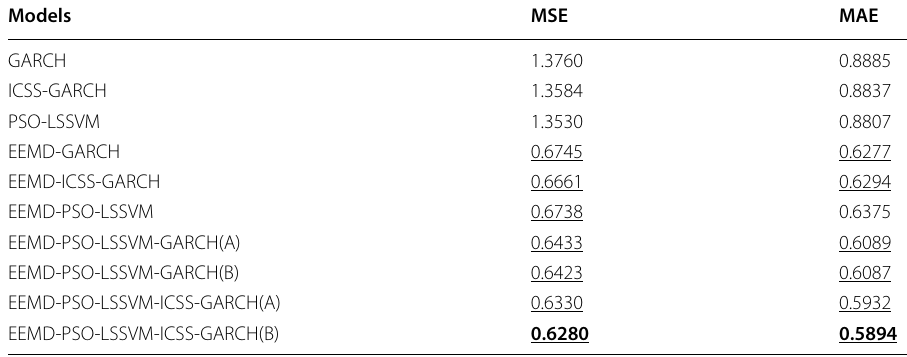
The numbers in the table refer to the values of the two loss functions. The bold numbers indicate that the corresponding models have the lowest forecasting losses. The underlined numbers indicate that the corresponding models are excluded in the MCS under the corresponding